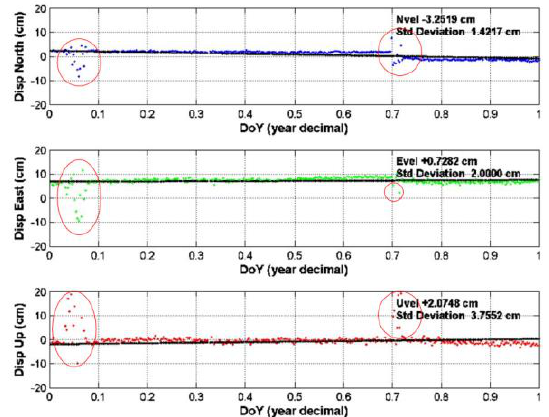
Figure 7. GPS-derived CTS at KUKP before removal of outliers.